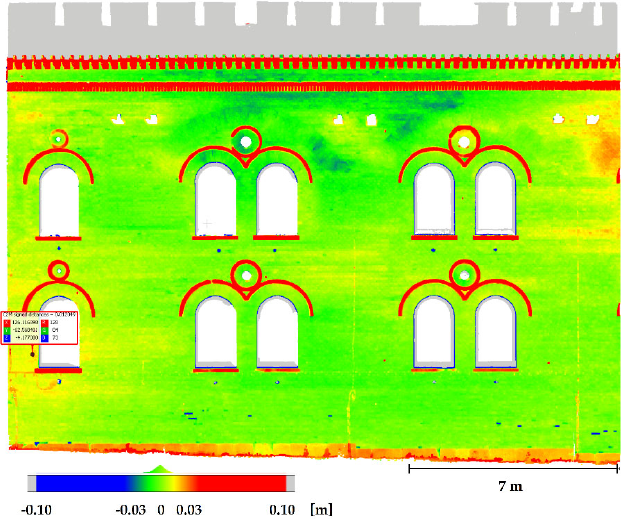
Figure 3. Deviation analysis of the wall